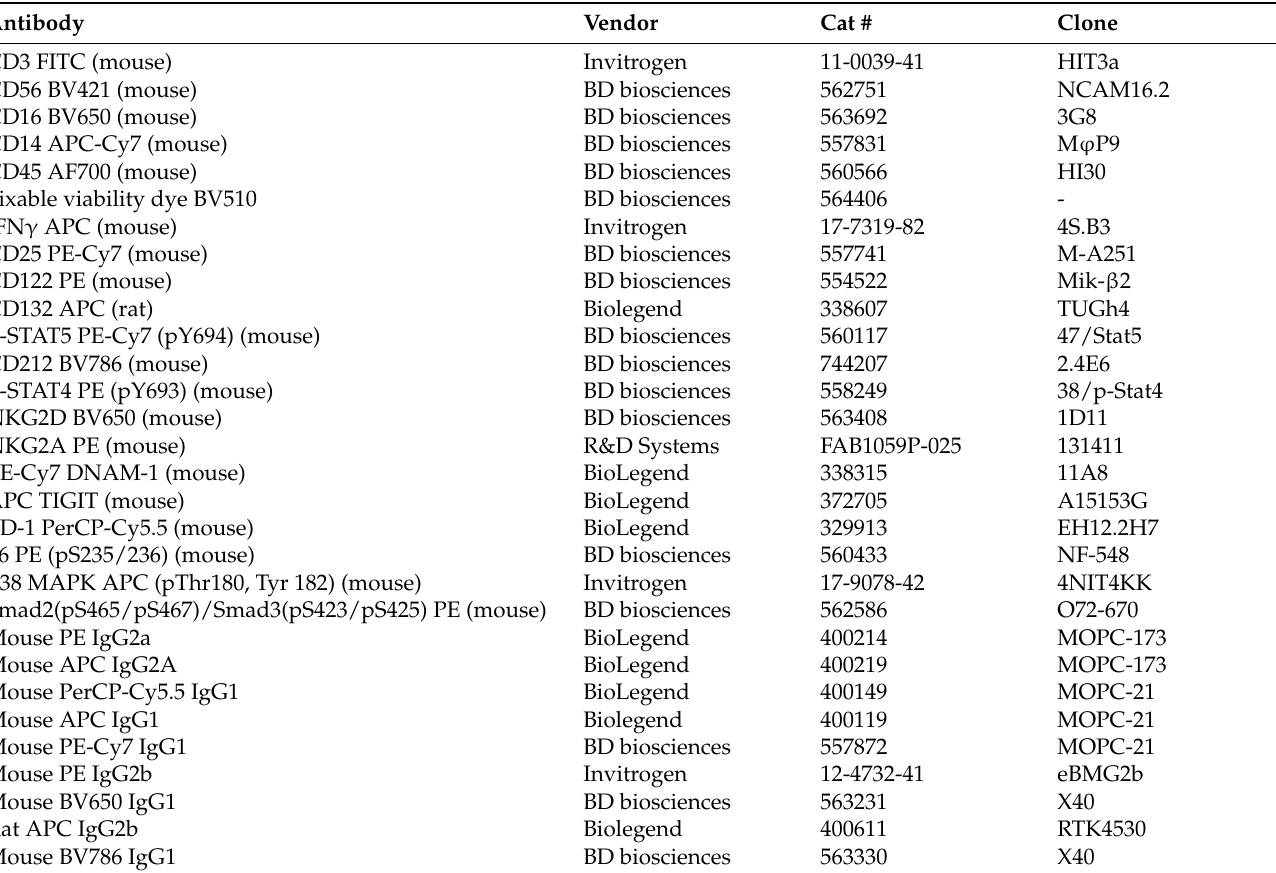
Table 1. FACS monoclonal